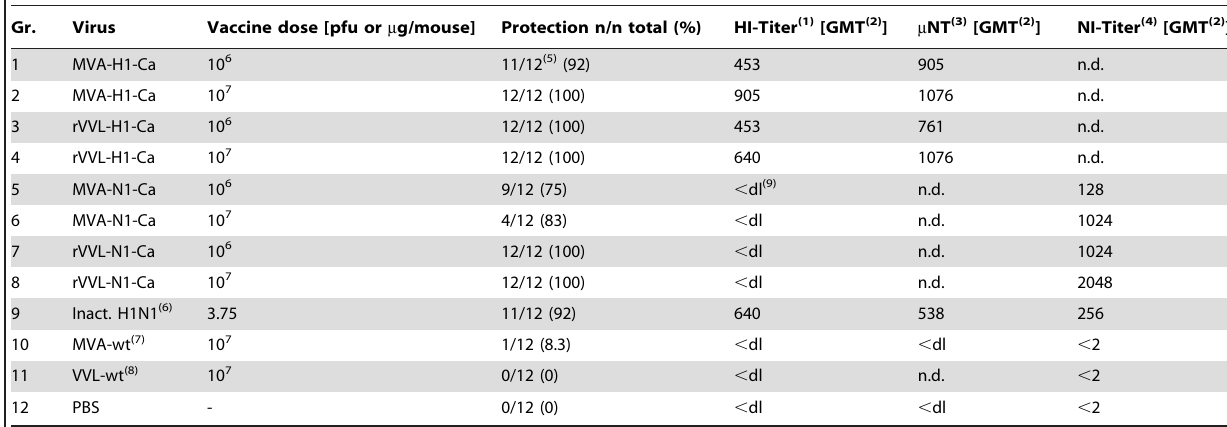
Table 2. Protection of mice from lung viremia and serology results after two vaccinations.